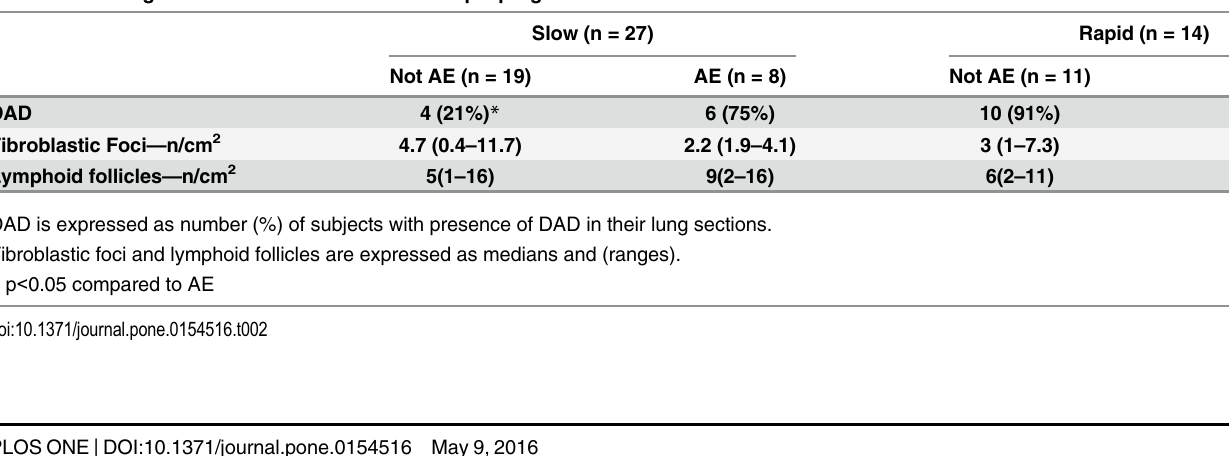
Table 2. Pathological characteristics of slow and rapid progressors with and without